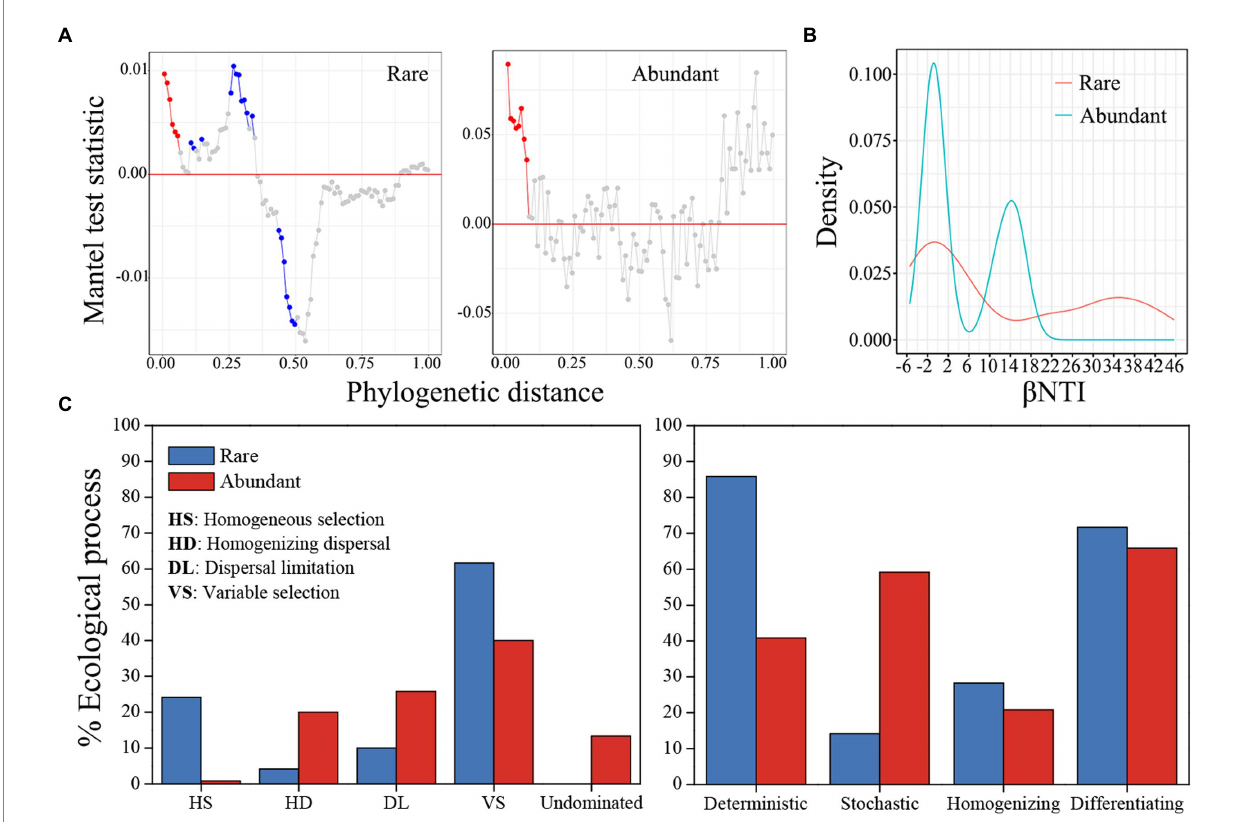
FIGURE 5 The rare and abundant bacterial subcommunity assembly. (A) Phylogenetic Mantel correlogram evaluating phylogenetic signals in rare and abundant bacterial subcommunities. Each point denotes the Mantel correlation coefficient between phylogenetic distances and ASV niche differences. Colors indicate significance (red, p < 0.01, blue, p < 0.05 and gray, p > 0.05). (B) Kernal density estimates for β NTI distributions for rare and abundant bacteria. (C) Null model-based ecological assembly processes of rare and abundant bacterial subcommunities.